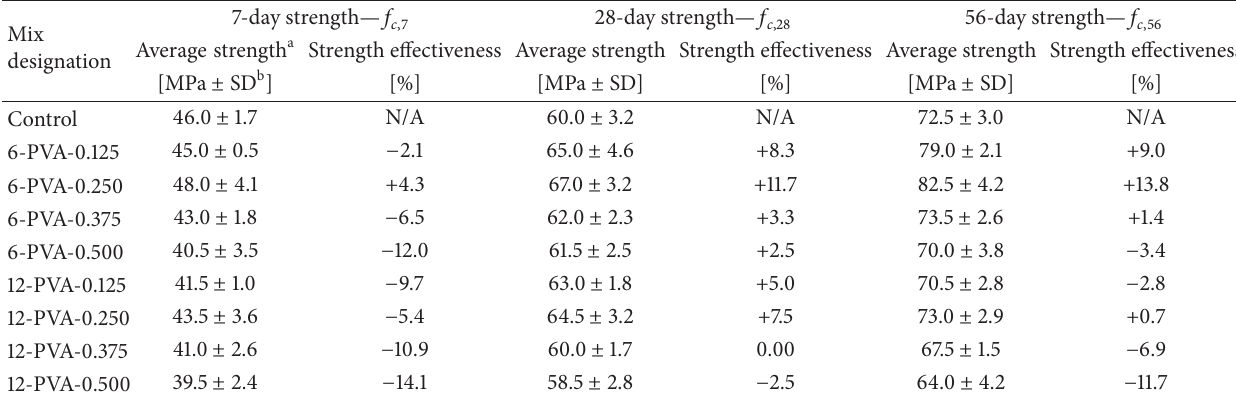
Table 6: Compressive strength of control and FRC at 7, 28, and 56 days.